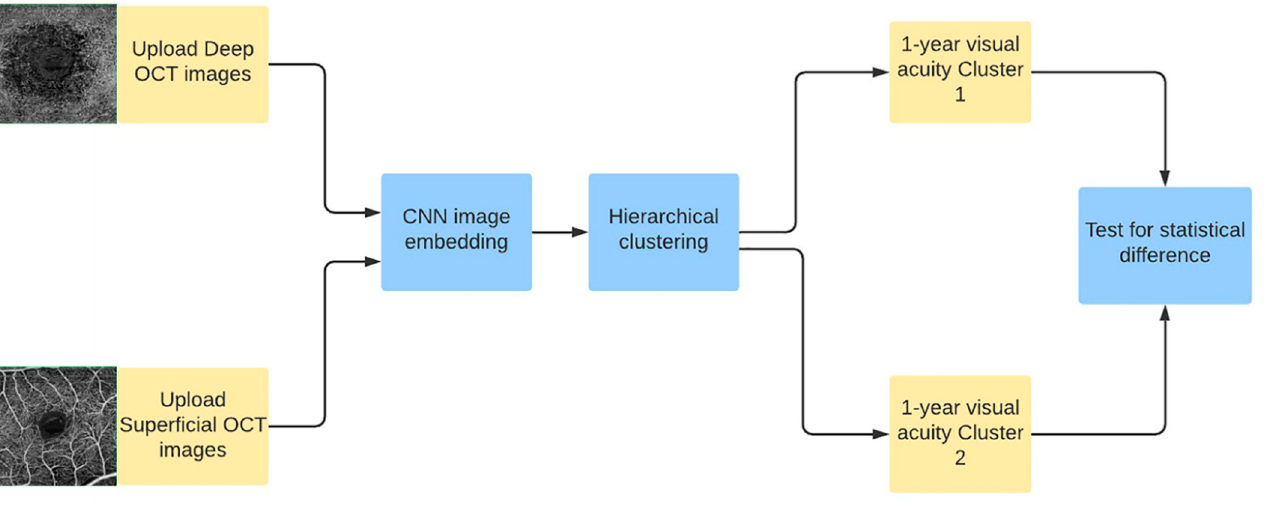
Figure 4. Schematic representation of the analysis workflow.